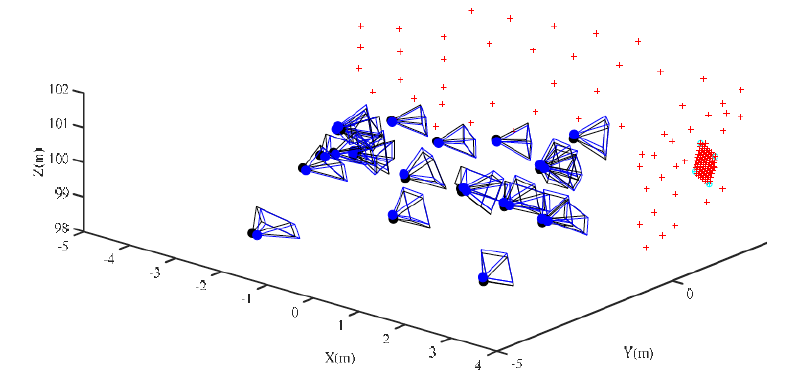
Figure 6. Network of evaluation image